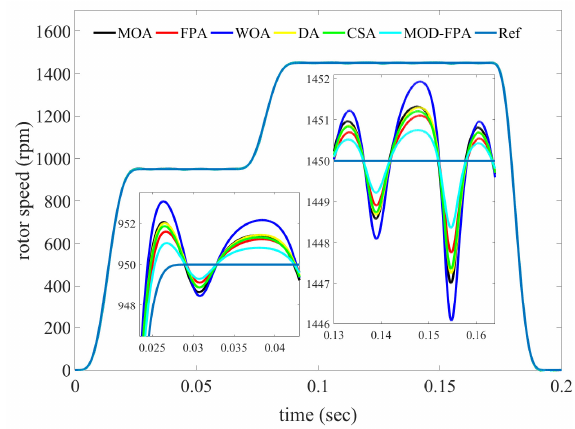
Figure 8. Simulation result for random load torque, varying set rotor speed and nominal parameters